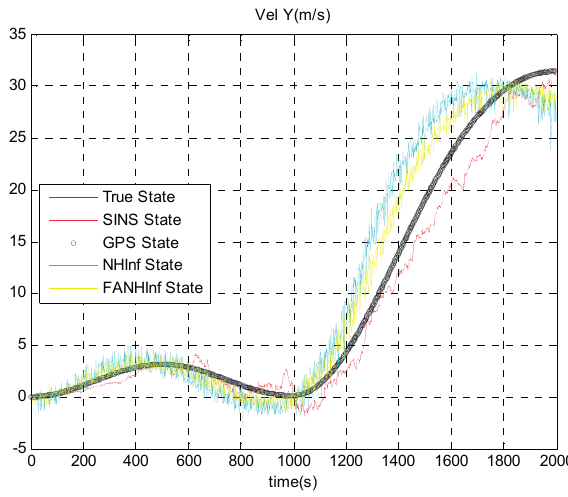
Figure 8. Estimation of the velocity following the East axis.